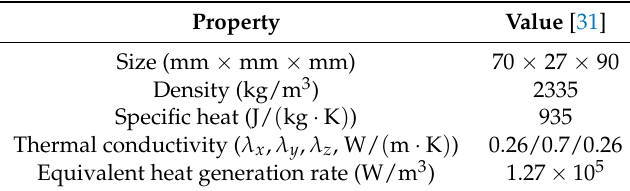
Table 3. Properties of battery cell used for testing the temperature calculation